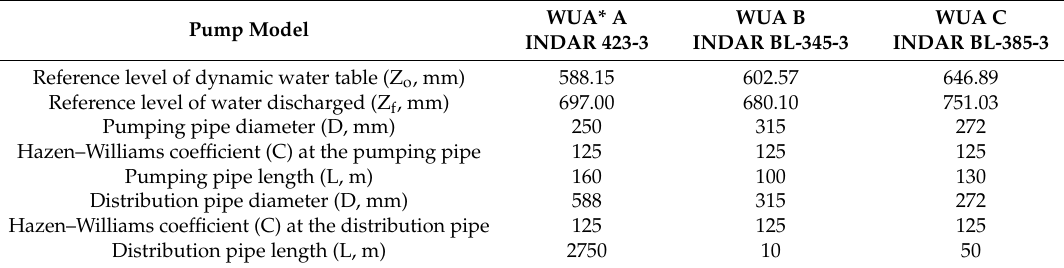
Table 2. General information required by the developed